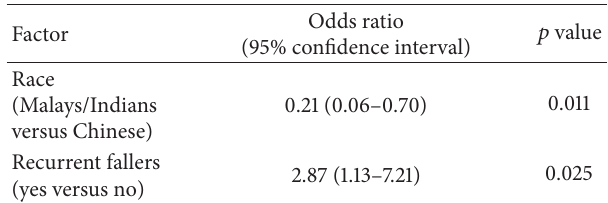
Table 4: Multivariate analysis of factors associated with vitamin D